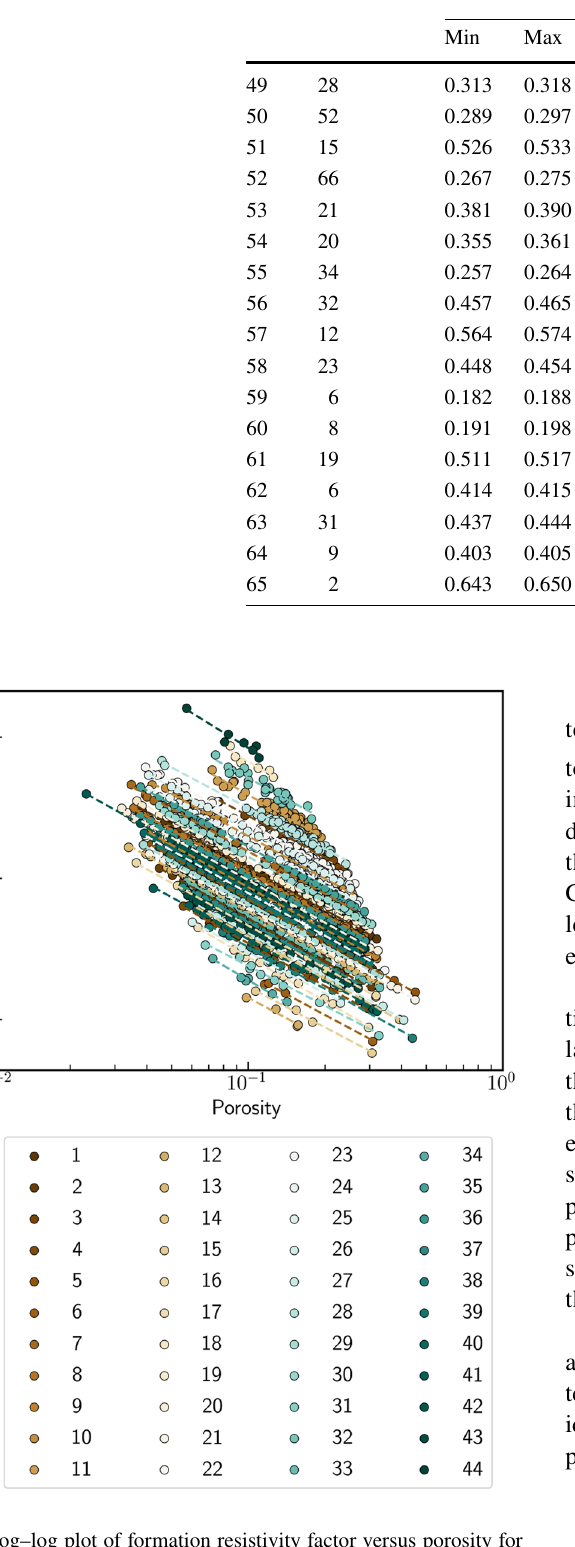
Fig. 6 Log–log plot of formation resistivity factor versus porosity for 44 ERTs with corresponding trendlines on training data from carbon- ate